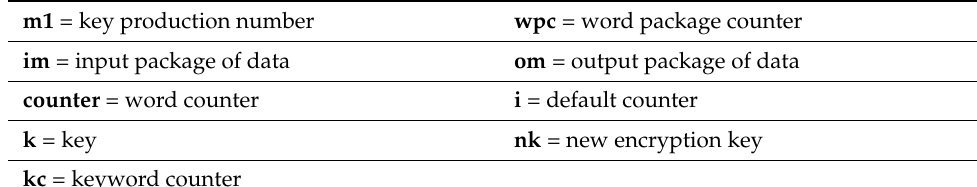
Table 6. Contents of the